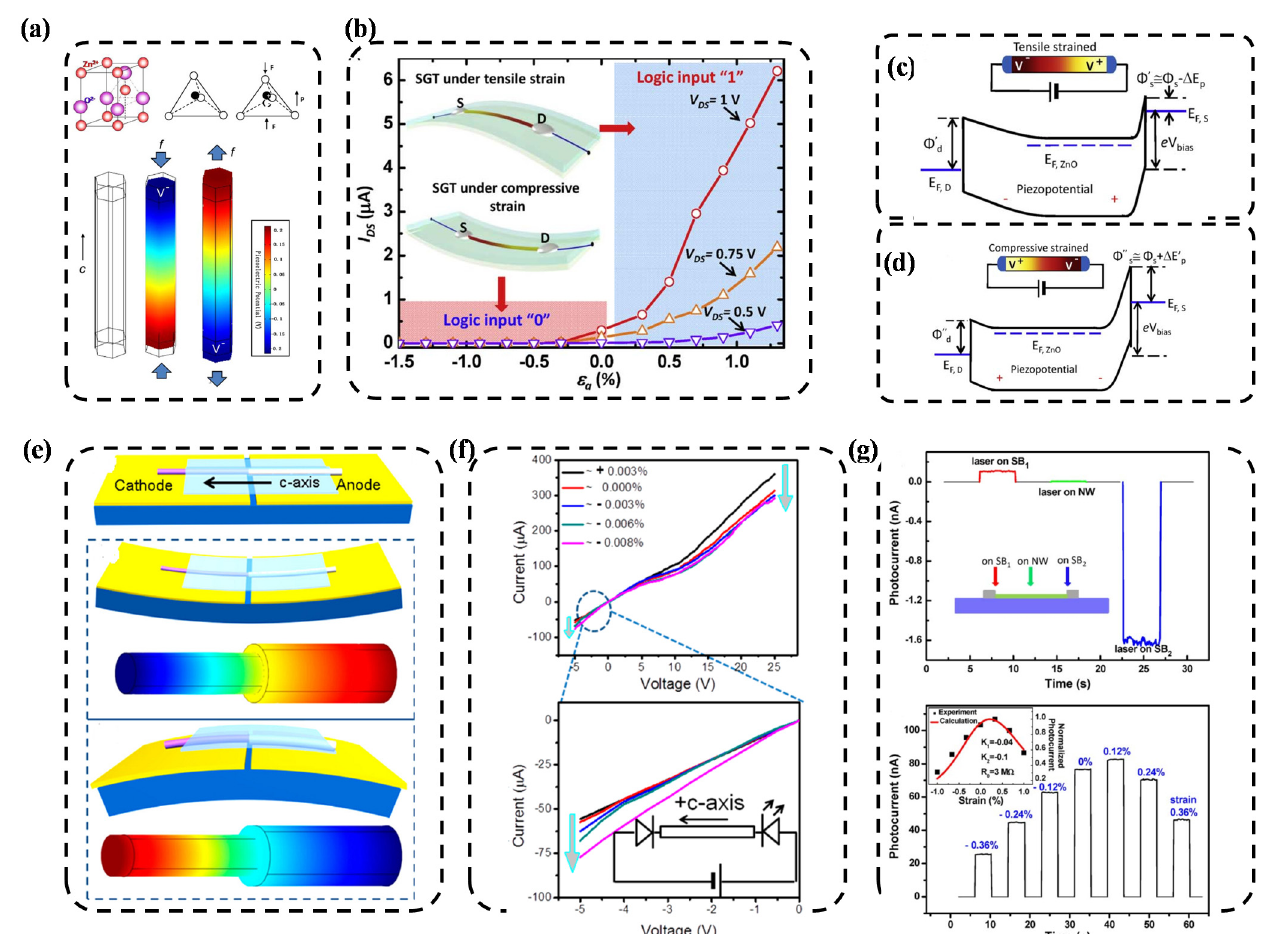
Figure 1. Fundamentals of the piezoelectric effect. ( a ) Crystalline model of the wurtzite-structured ZnO (upper panel); numerical simulation of the piezoelectric potential distribution in a ZnO nanowire under axial strain. The growth direction of the nanowire is the c-axis. The dimensions of the nanowire are L = 600 nm and a = 25 nm; the external force is fy = 80 nN (bottom panel). Reproduced with permission from Ref. [10]. Copyright 2009 American Institute of Physics. ( b ) Transfer characteristics of the current strain ( I DS - ε ) for a ZnO SGT device, with the strain sweeping from ε = − 0.53% to 1.31% at a step of 0.2%, where the V DS bias values were 1 V, 0.75 V and 0.5 V, respectively. ( c ) Under tensile strain, the SBH at the source side is reduced from φ s to φ s’ ≈ φ s − Δ E P . ( d ) Under compressive strain, the SBH at the source side is raised from φ s to φ s’’ ≈φ s + Δ E P’. ( e ) Schematic of the device (top panel), stimulation of piezopotential at compressive strain state, (middle panel) and at tensile strain state (bottom panel). The color gradient represents the distribution of piezopotential, with red for positive and blue for negative potentials. ( f ) Upper panel: piezotronic performances of the device under various strain levels. ( e ) Bottom panel: magnification of the characteristics for the negative voltage range. Reproduced with permission from Ref. [13]. Copyright 2012 American Chemical Society. ( g ) Maximizing the photocell output by the piezophototronic effect. Upper panel: The output current, as the laser spot, was focused at different positions of the wire. The inset shows the sketched picture to indicate the related illuminating position of the laser on the device. Bottom panel: Output current responses to the strain applied on a device. The inset is the simulated result based on an equivalent circuit model. Reproduced with permission from Ref. [16]. Copyright 2013 American Chemical Society.